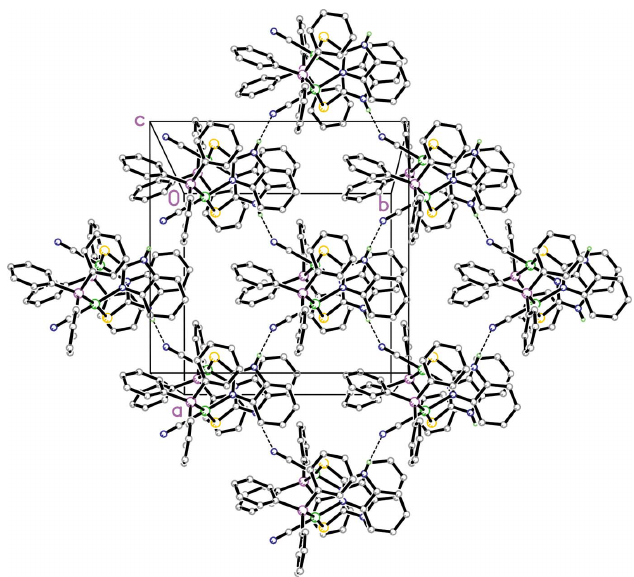
Figure 3 Diagram showing the packing for 1 showing the two intermolecular C 1 (7) 1 N—H (cid:2)(cid:2)(cid:2) N hydrogen-bonded chains in the [110] and [110] directions. Hydrogen atoms not involved in hydrogen bonding are omitted for clarity. Symmetry operation to generate the rest of the molecule is (cid:3) x , y , 1 (cid:3) z 2 N—H group of the thione moiety forms an intermolecular hydrogen bond with an adjacent N atom from the coordinated cyanide anion and these form C 1 (7) chains (Etter et al. , 1990) 1 in the [110] and [110] directions. In addition, in 2 there are also C—H (cid:2) (cid:2) (cid:2) N interactions between the imidazoline rings and the partially occupied acetonitrile N atoms and this is shown in Fig. 5.